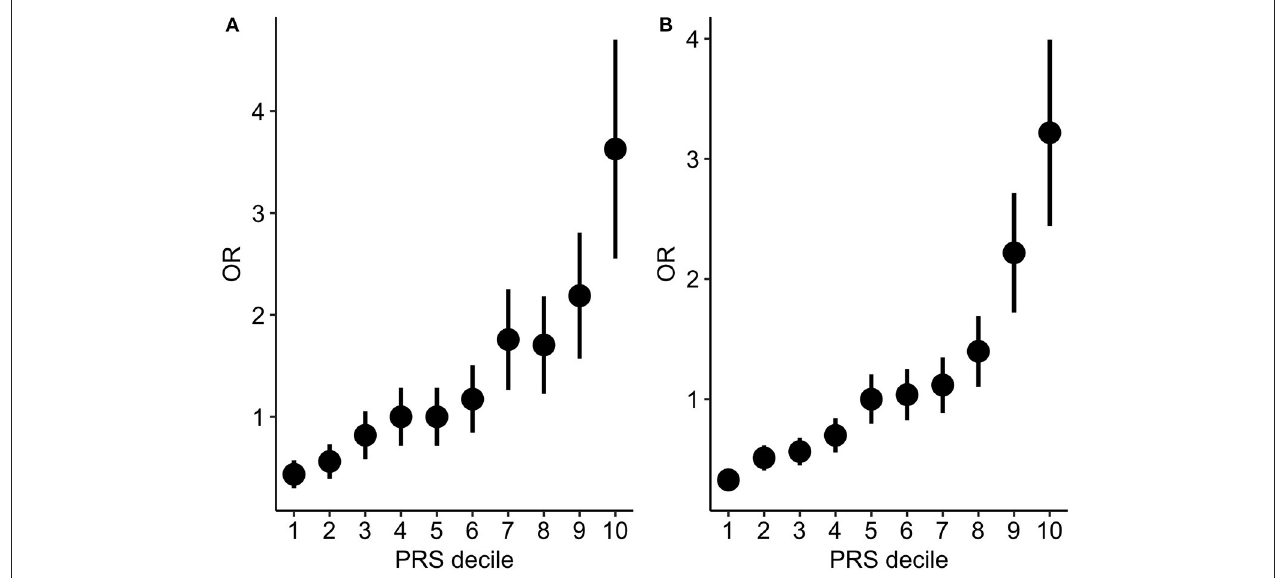
FIGURE 3 | PRS stratification for hypertension risk. ORs between hypertensive cases and normotensive controls by grouping the samples according to the PRS deciles ( A : target cohort; B : validation cohort). The points represent the OR point estimates and the lines represent the corresponding standard